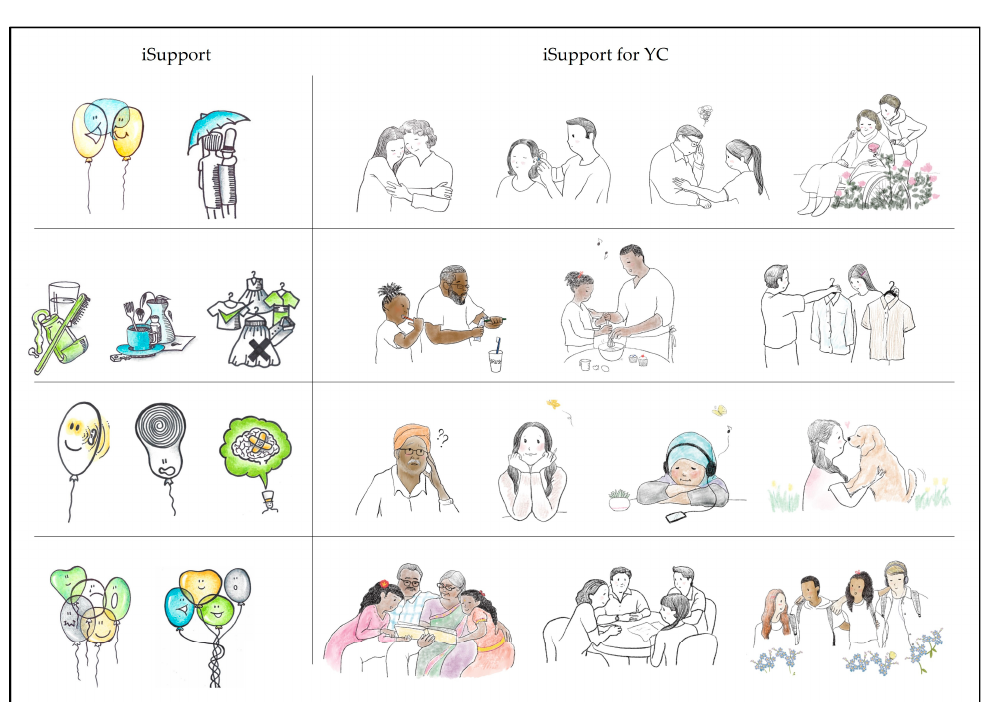
Figure 4. Examples of human characters replacing the original illustrations.